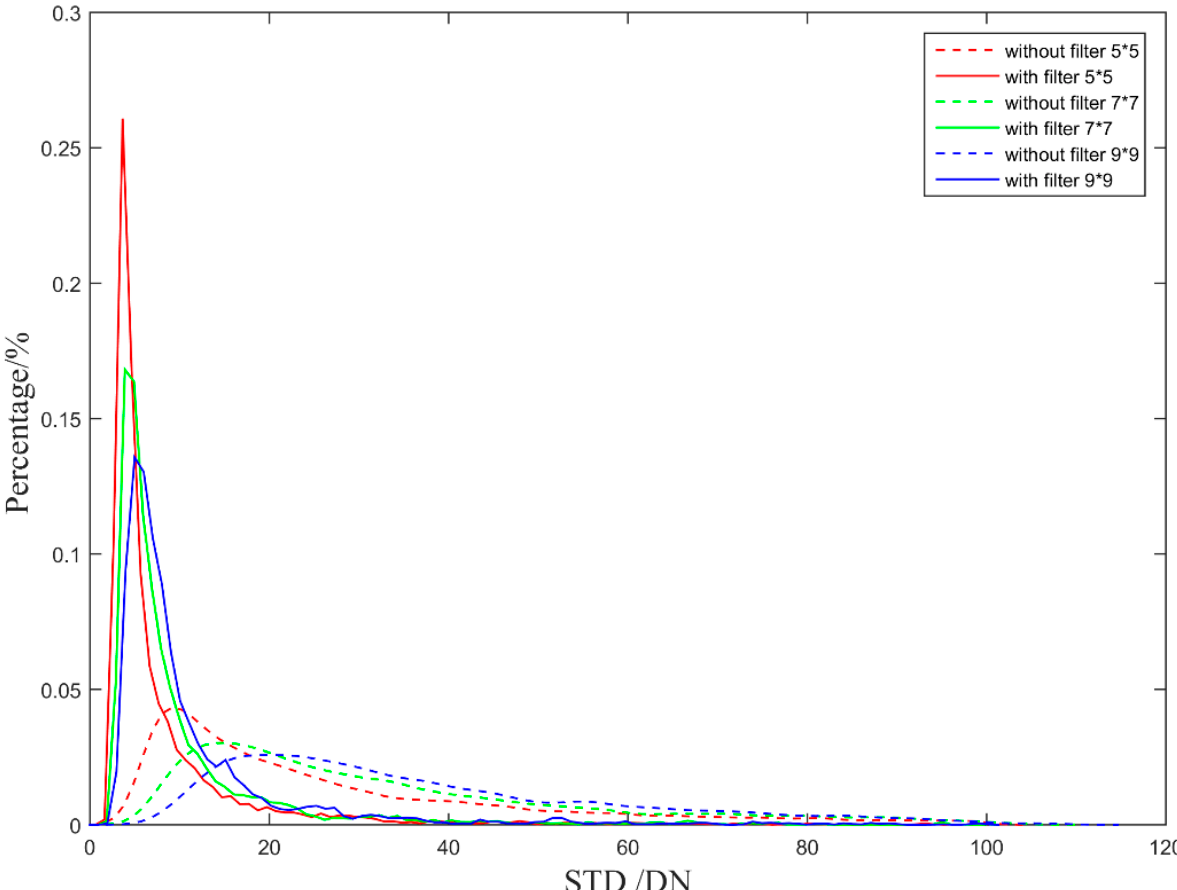
Figure 24. Local regional standard deviation (STD) probability distribution curve comparison of the corrected images.